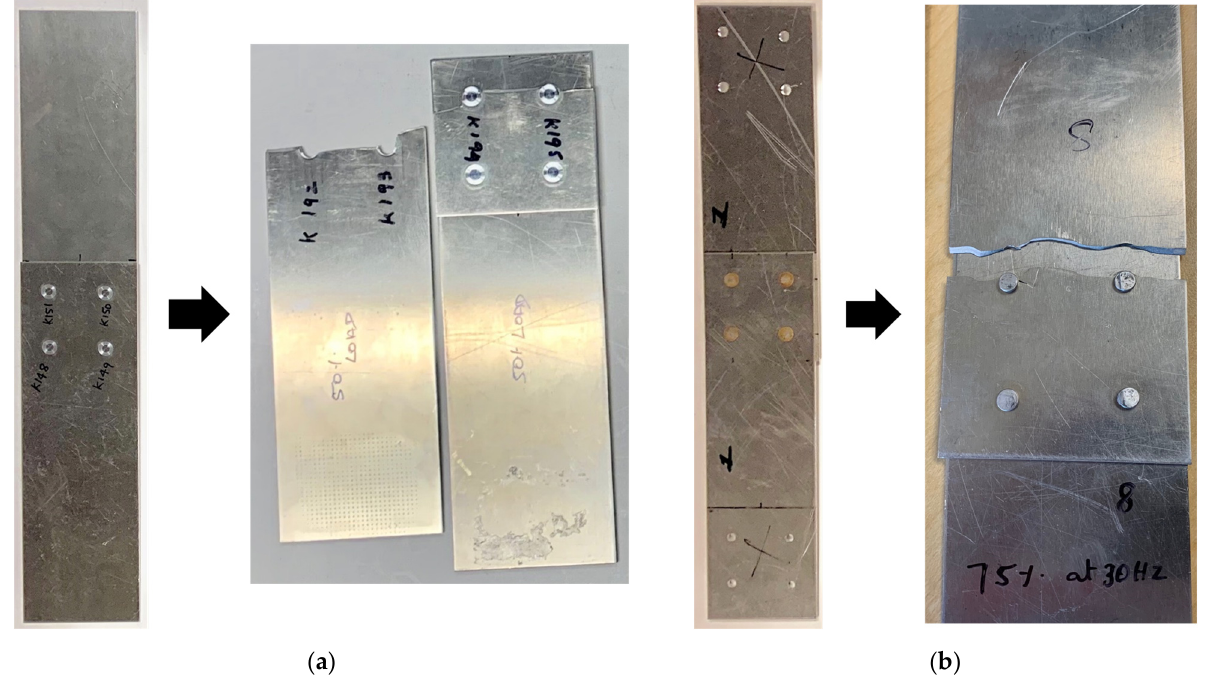
Figure 12. Four-spot coupons before and after fatigue lap shear pull tests: ( a ) 4-refill-spot-weld coupon ( left ) and tensile failure of stiffener piece ( right ); ( b ) 4-rivet-joint coupon ( left ) and tensile failure of stiffener piece ( right ). The images may have different scaling for clarity.